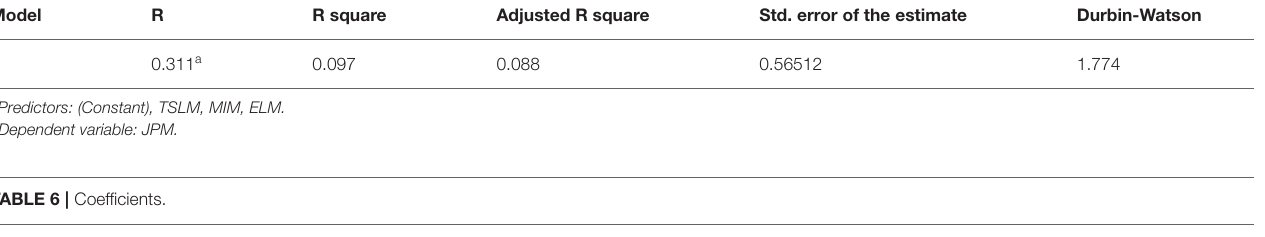
TABLE 5 | Model summary. Model